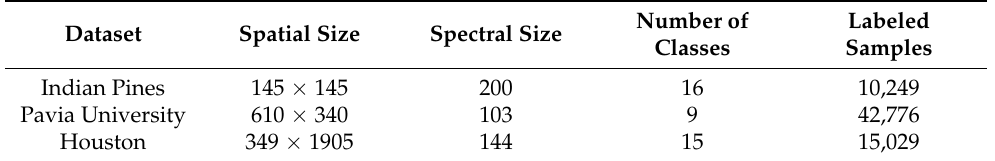
Table 1. Basic information of each HSI dataset.